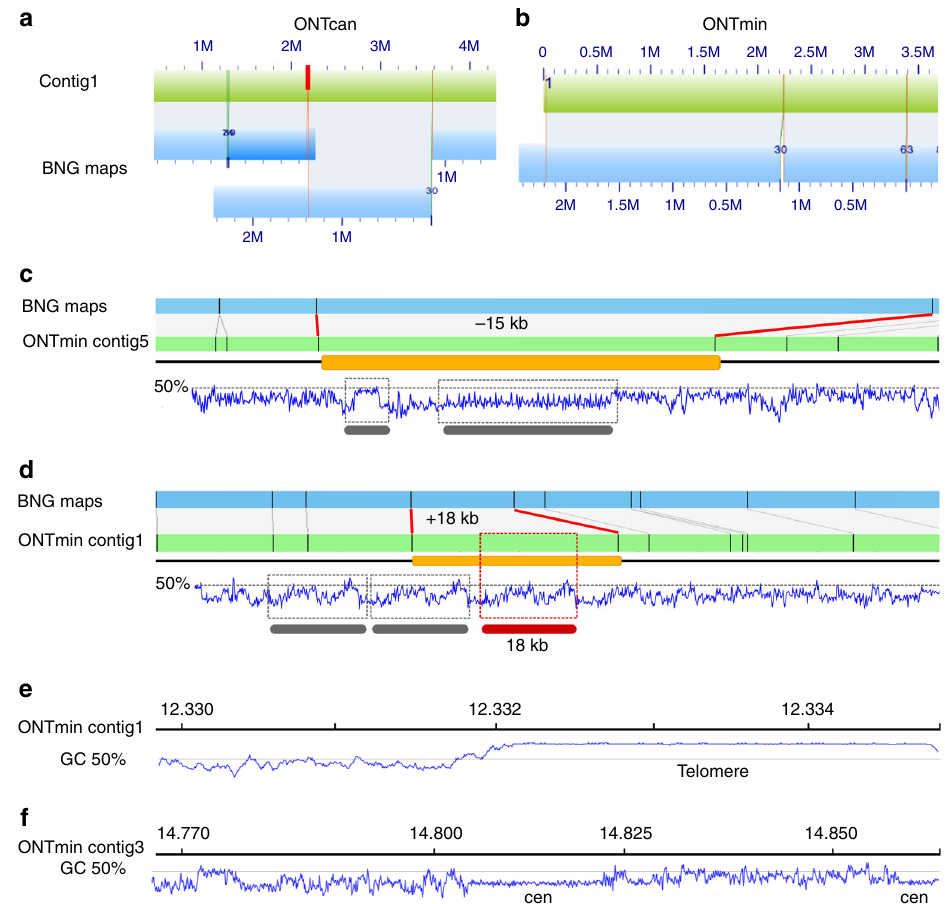
Fig. 3 Bionano Genomics maps identify mis-assemblies and hard to assemble regions in the Oxford Nanopore MinION assembly. BNG cmap_30 (blue; marked as 30) identi fi ed a a chimeric ONTcan contig 1 (green) and b the correct assembled contig 1 in the ONTmin assembly (green). The chimeric position is indicated with a red bar. c A collapsed region in ONTmin contig 5, in which approximately 15 kb sequences are missing from one of the two potential repeat regions as identi fi ed by the GC pattern (gray bars). In contrast, d shows a falsely duplicated region of approximately 18 kb, with the duplicated repeat region highlighted (red bar, 18 kb). e ONTmin assembly resolves various telomere regions, for example after 12.332 Mb on contig 1, as outlined by a GC plot (blue line). f ONTmin also resolves short centromere arrays as shown toward the end of contig 3 (blue, GC